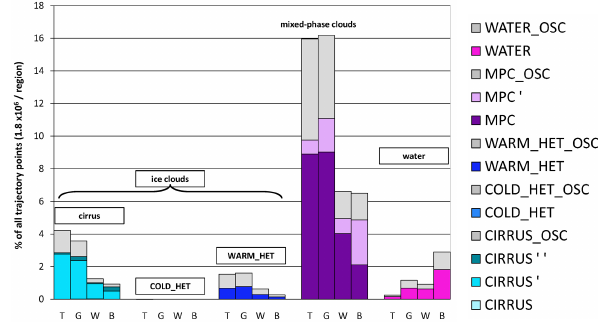
Fig. 5. The breakdown of only those trajectory points classified as cloudy in each geographic region (i.e. sum of last two lines in Ta- ble 1): Taklimakan (T), Gobi (G), West Africa (W) and Bod´el´e (B). Note that cloud types CIRRUS, COLD HET and COLD HET OSC are not visible on this scale. See Table 2 for tabular